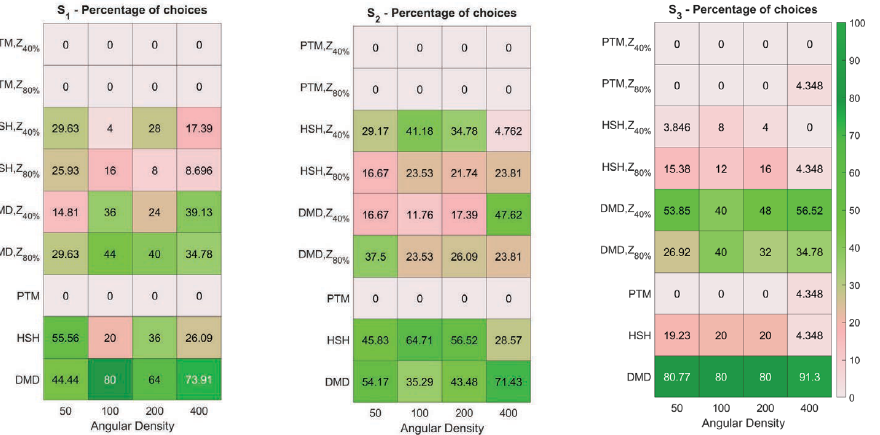
Figure 9. Mean of scores of consistent voting sequences per experiment parameter P 1 ment surfaces S 1–3 .